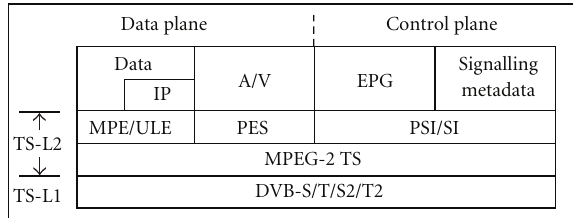
Figure 1: Current DVB MPEG-2 TS